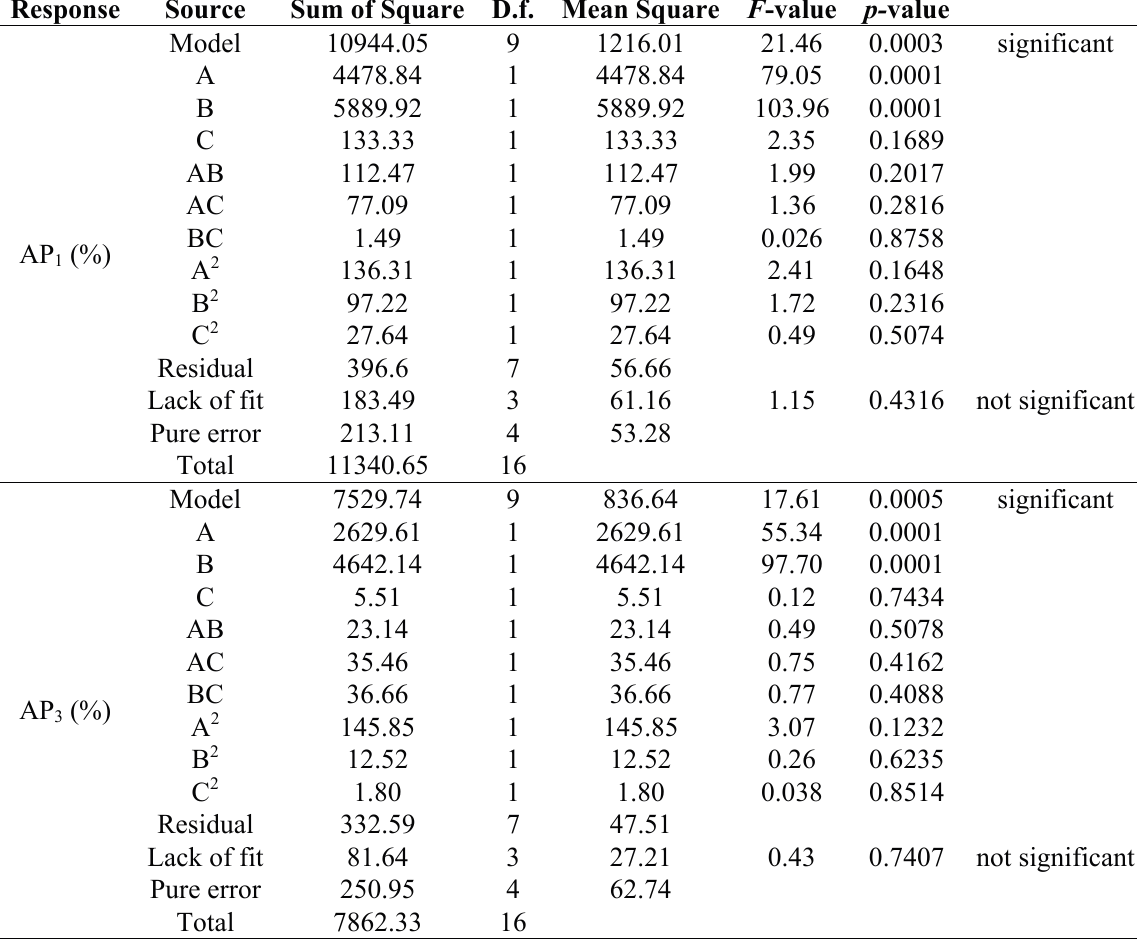
Table 4. Analysis of variance (ANOVA) for the regression